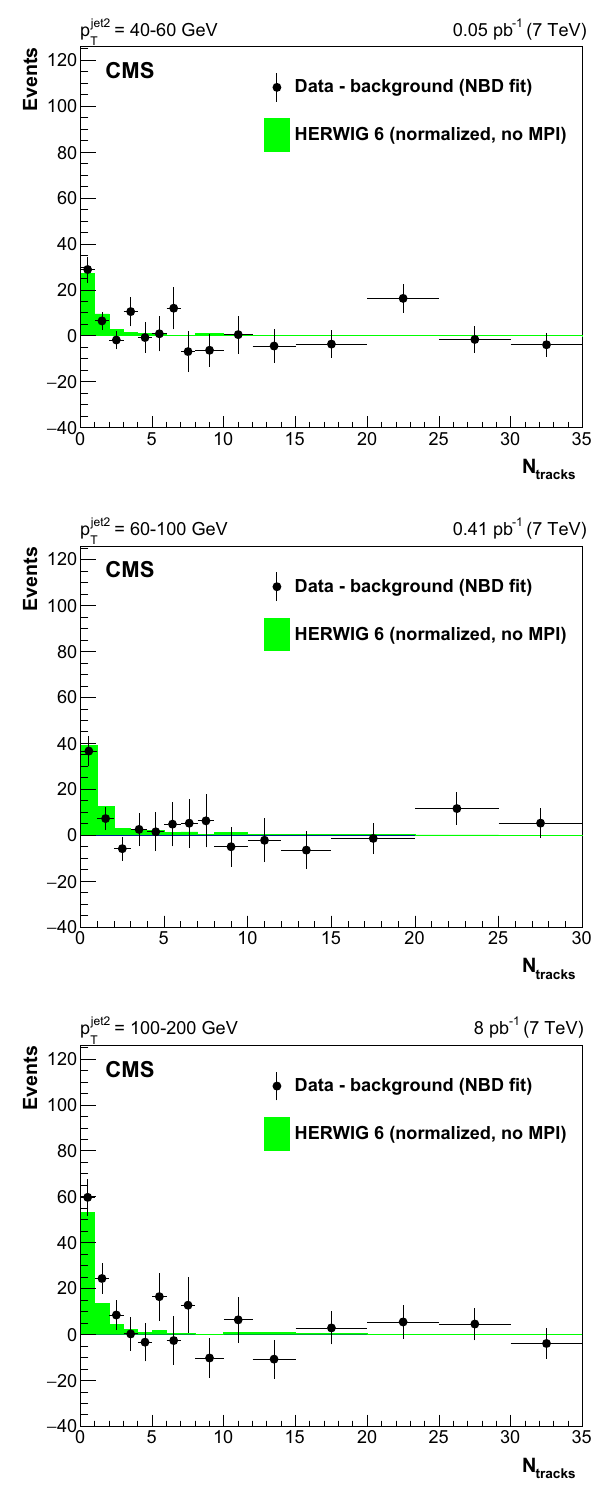
Fig. 7 Background-subtracted central track multiplicity distributions, uncorrected for detector effects, in the three bins of p jet2 to the herwig 6 predictions without underlying event simulation (“no MPI”), normalized as in Fig. 3. The background is estimated from the NBD fit to the data in the 3 ≤ N tracks ≤ 35 range, extrapolated to